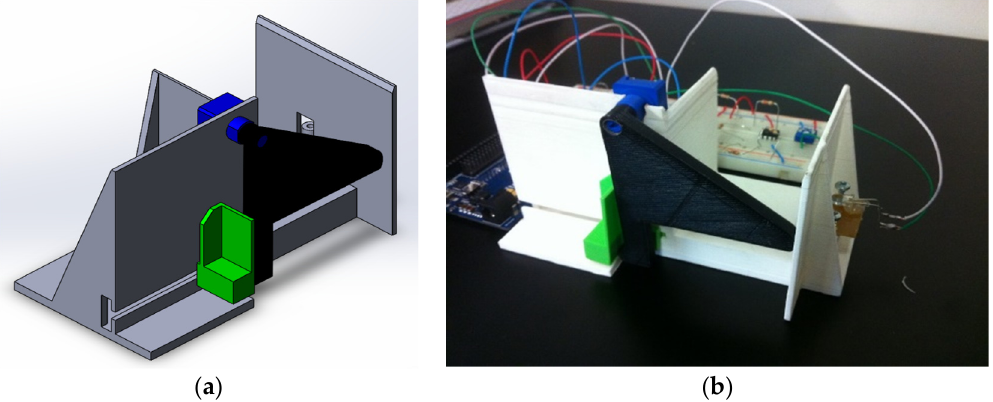
Figure 29. System for measuring the thickness of a document by the principle of a potentiometer: ( a ) the CAD model; ( b ) the prototype developed by 3D printing.